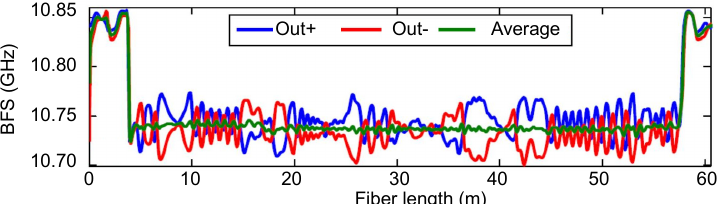
Fig. 14 | The measured BFS of two symmetrical outer cores when the MCF was spooled with random orientations; the green trace is the averaged BFS of two symmetrical outer cores. Figure reproduced from ref. 56 , Optical Society of